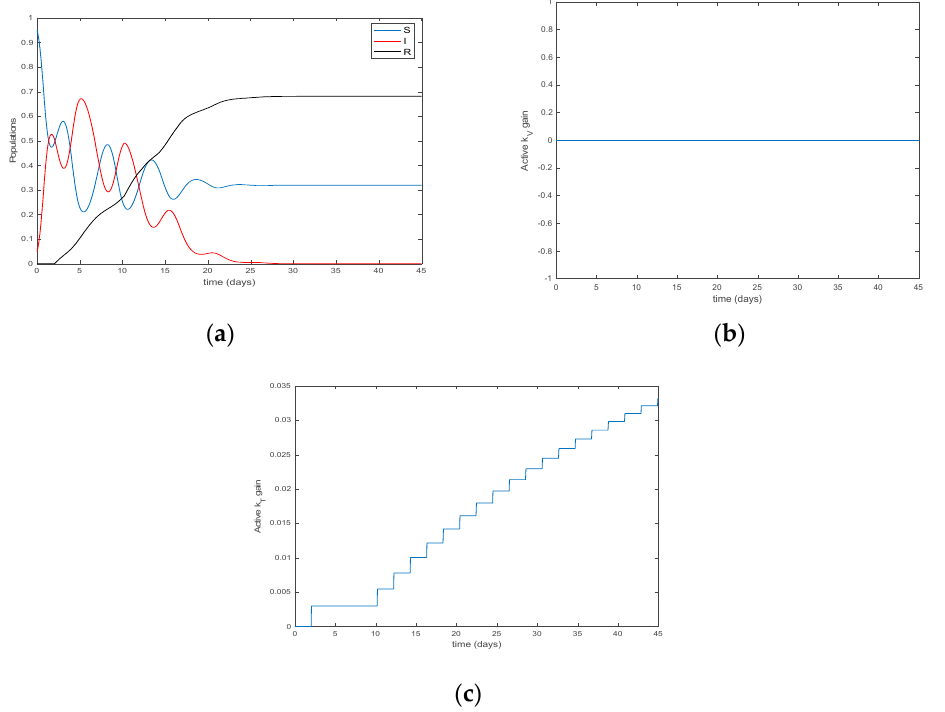
Figure 9. Performance of the system with seasonal incidence rate and vaccination and treatment actions tuned by Algorithm 4. ( a ) Evolution of model’s populations. ( b ) Active gain k V ( t ) . ( c ) Active gain k T ( t ) .